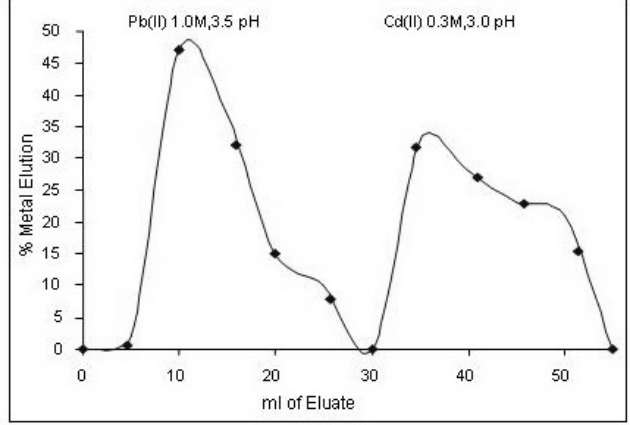
Figure 6 . Separation of Pb(II) and Cd(II) on AFM